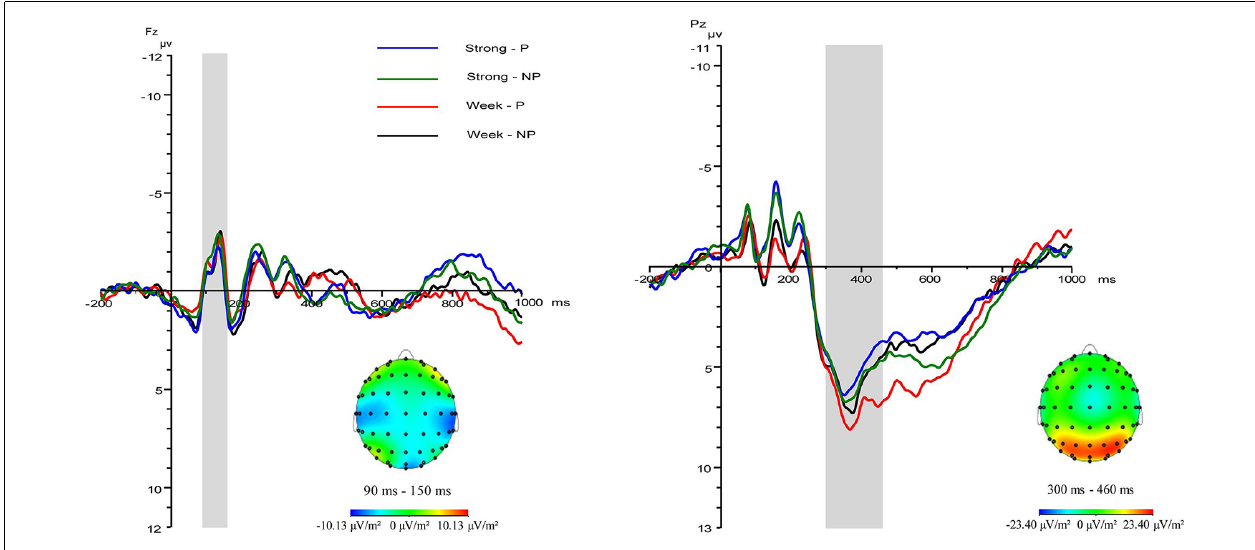
FIGURE 4 | Grand mean waveforms of event-related potential (ERP) evoked by painful and non-painful stimuli in pre-teachers with different levels of professional identity. Strong-P/NP represent painful and non-painful stimulus, respectively, in participants with strong professional identity; Weak-P/NP represent painful and non-painful stimulus, respectively, in participants with weak professional